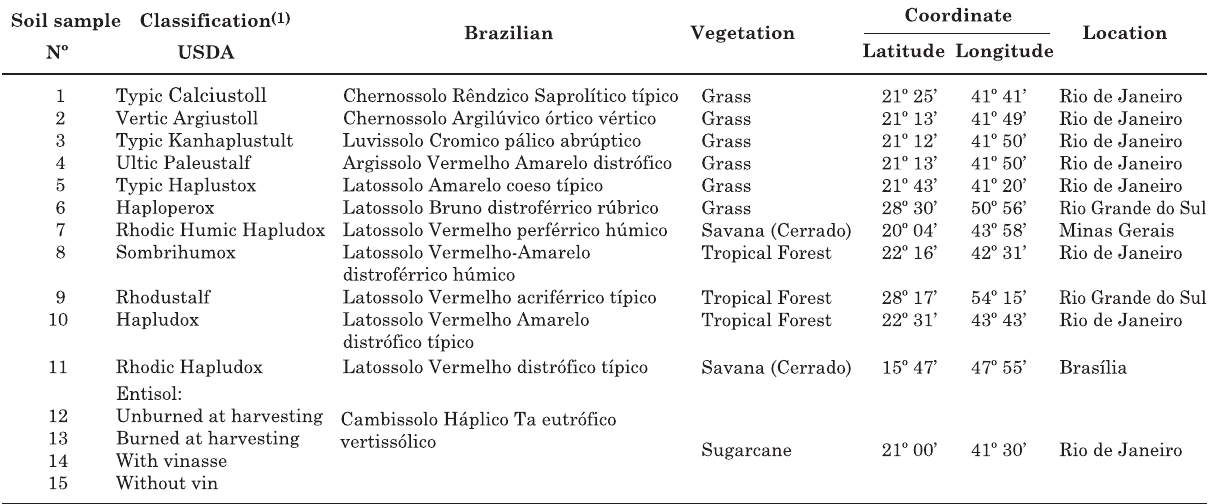
Table 1. Classification, vegetation, coordinates and location of the soil